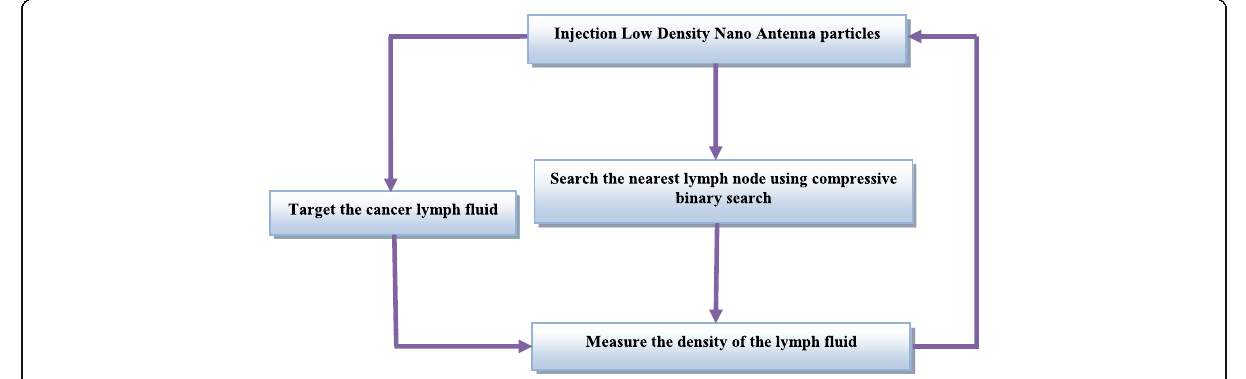
Fig. 3 Sending process of the fighting nanoparticles to cancer